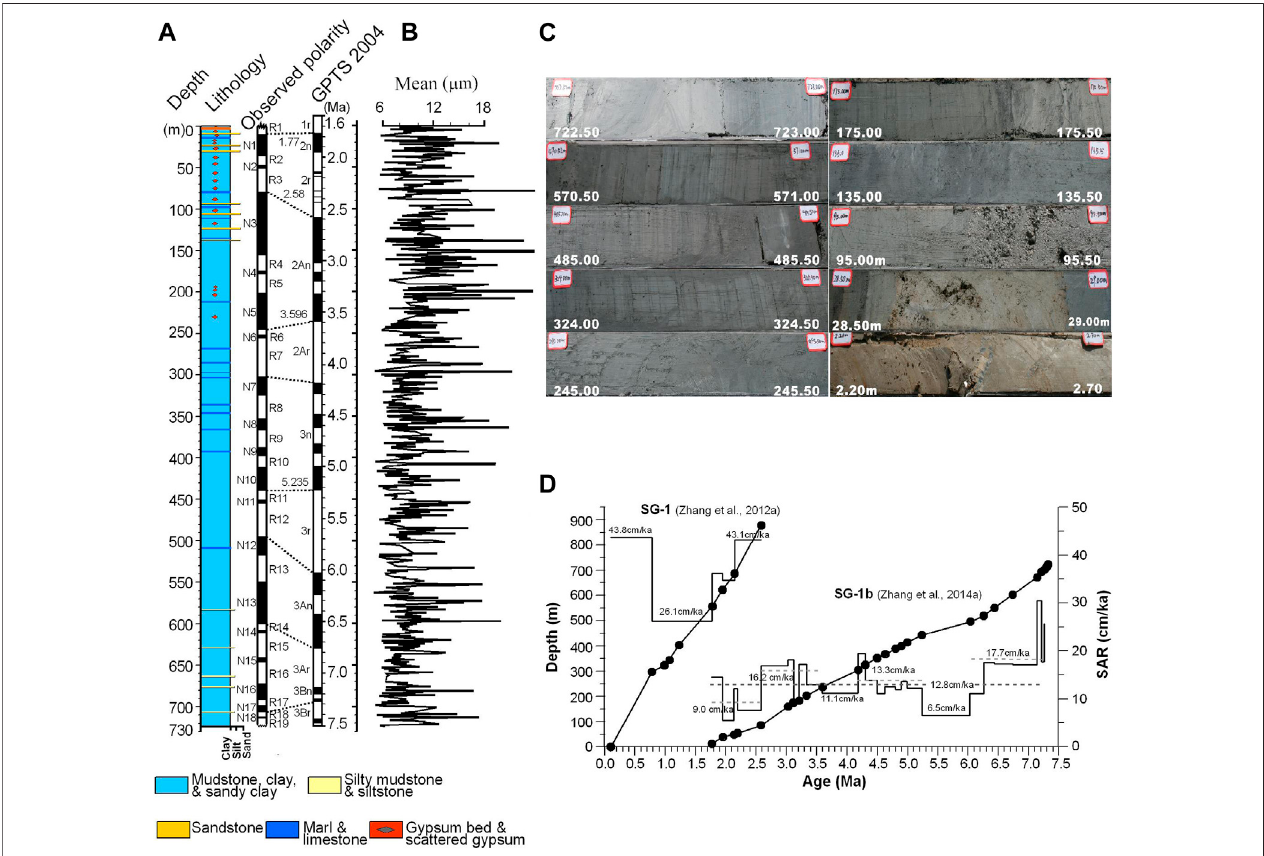
FIGURE 2 | (A) SG-1b core lithology and magnetostratigraphy (after Zhang et al., 2014b). (B) Variations in mean grain size fractions in the SG-1b (derived from Lu et al., 2015). (C) Photographs of selected sliced cores between 723 m and 0 m ( ∼ 7.3 – 1.6 Ma). (D) Depth – age plot for the cores SG-1 (Zhang et al., 2012b) and SG-1b (Zhang et al., 2014a) based on the correlation of the polarity sequence with the geomagnetic polarity timescale of Gradstein et al. (2004).